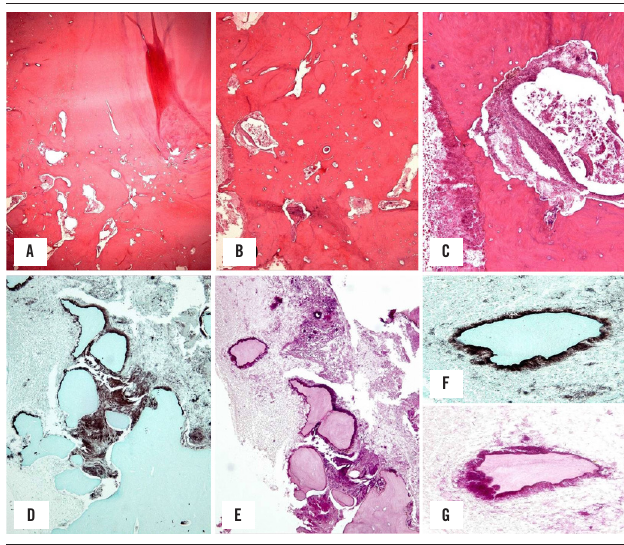
FIGURA 3 – Visão microscópica (coloração HE) A) interface mostrando o contato intrínseco entre a raiz dentária e a hiperplasia do cemento (5×); B) hipercementose com cavidades irregulares, algumas vazias (5×); C) área